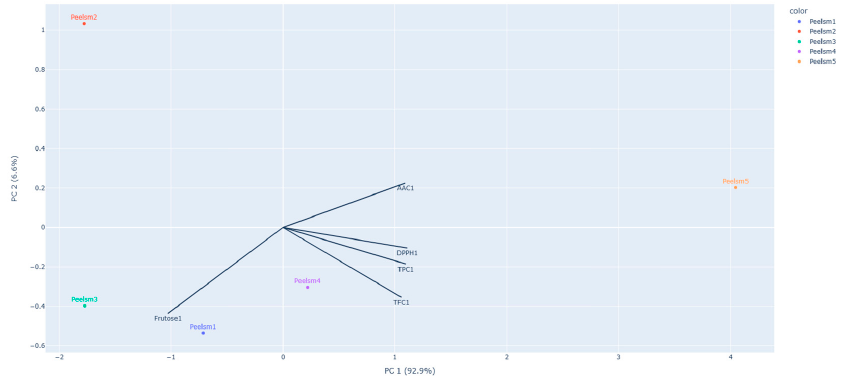
Figure 3. Biplot PC2 vs. PC1 for the peel moiety of the different apple varieties. (Peelsm1: Peel of Pêro Coimbra Apple, Peelsm2: Peel of Pardo Lindo Apple, Peelsm3: Peel of Repinau Apple, Peelsm4: Peel of Pêro de Borbela Apple, Peelsm5: Peel of Noiva Apple).